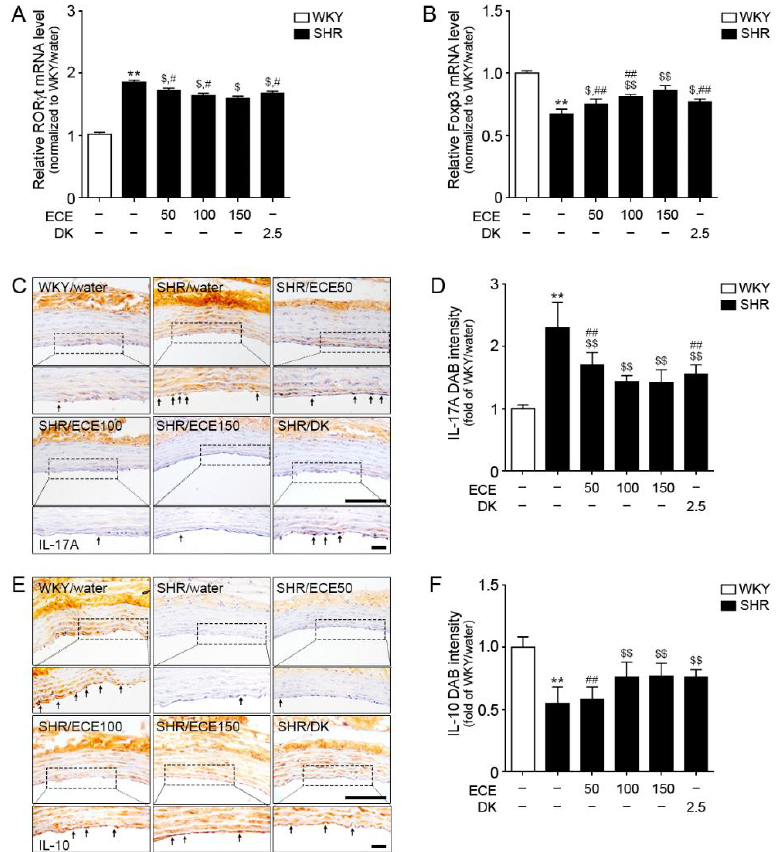
Figure 3. Regulatory effects of DK and ECE on Th17 and Treg cell levels in the aorta of SHRs. ( A ) In the aorta tissue, ROR γ t mRNA levels were increased by SHR/water. The addition of ECE and DK decreased the ROR γ t and Foxp3 mRNA levels. ( B ) Foxp3 mRNA level in the aorta tissue was decreased following SHR/water and increased following ECE or DK treatment. ( C , D ) The IL-17A expression level in aorta tissue was increased following SHR/water and decreased following ECE or DK treatment. ( E , F ) The IL-10 expression level in aorta tissue was decreased following SHR/water and increased following ECE or DK treatment. For each of the 6 groups, n = 5. Scale bar = 100 µ m. **, p < 0.01 vs. WKY/water; $, p < 0.05 and $$, p < 0.01, vs. SHR/water; #, p < 0.05 and ##, p <